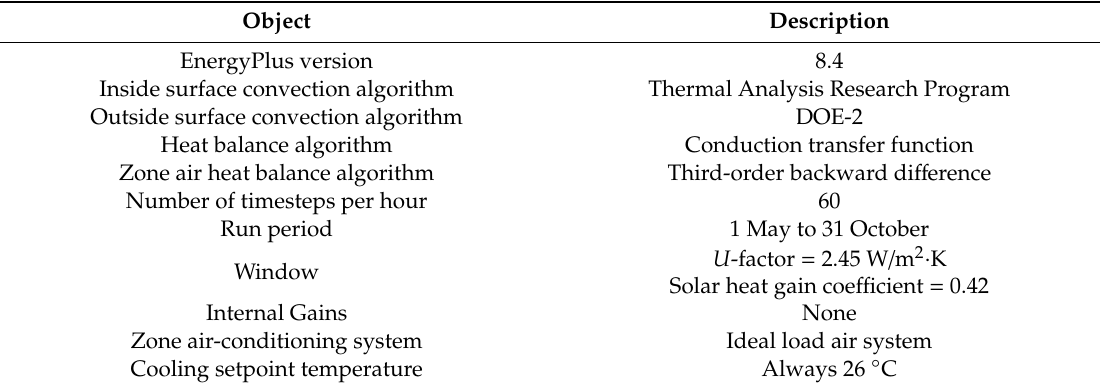
Table 7. EnergyPlus simulation